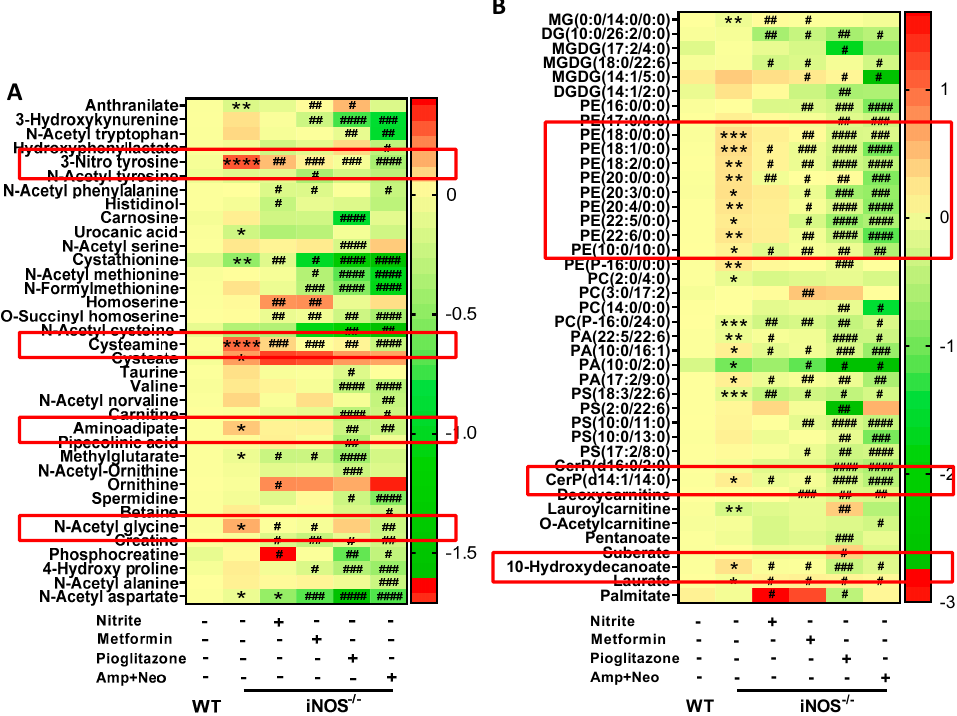
Figure 6. Alterations in the amino acid and lipid metabolites in iNOS -/- mice following treatment with various interventions. Heat map of differential metabolites found by metabolomics analysis related to ( A ) Amino acids metabolism and ( B ) Lipid metabolism. Data are represented as mean ( n ≥ 4). * p < 0.05, ** p < 0.01, *** p < 0.001, **** p < 0.0001 vs. WT; # p < 0.05, ## p < 0.01, ### p < 0.001 and #### p < 0.0001 vs. iNOS -/- . MG: Monoacylglycerols, DG: Diacylglycerols, MGDG: mono- galactosyldiacylglycerol, DGDG: digalactosyldiacylglycerol, PE: Phosphatidylethanolamine, PC: Phosphatidylcholine, PA: Phosphatidic acid, PS: Phosphatidylserine and CerP: Ceramide